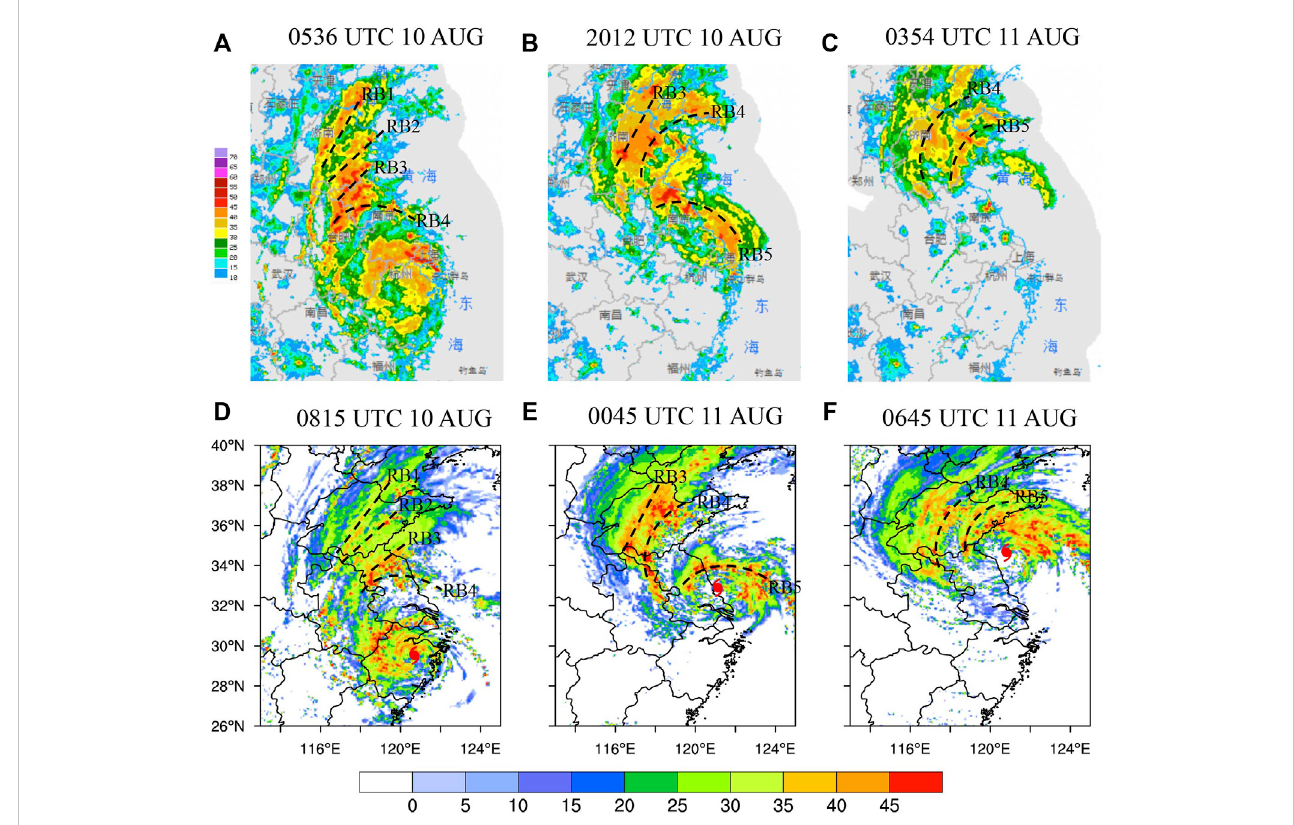
FIGURE 5 Observed (A – C) andsimulated (D – F) compositeradarre fl ectivities(unit:dBZ).Observation: (A) 0536UTC10August2019, (B)